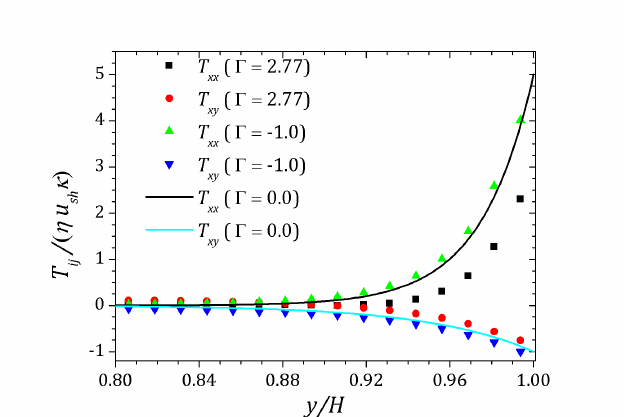
Figure 13. Effect of application of the pressure gradient on stress tensor. Normal and shear stress for De κ = 2.5, ε = 0.1 e κ =